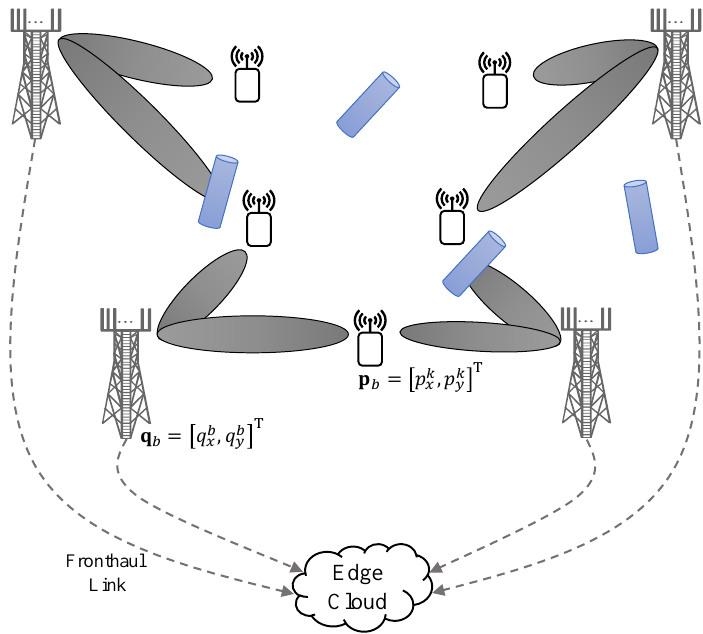
Figure 1. Uplink Communication system model showing receivers (BSs) and transmitters (users) with the LoS link and random